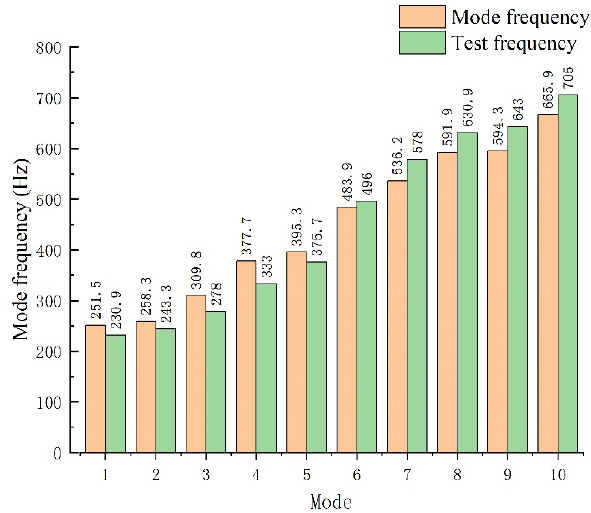
Figure 9. Mode analysis resonance frequency comparison.